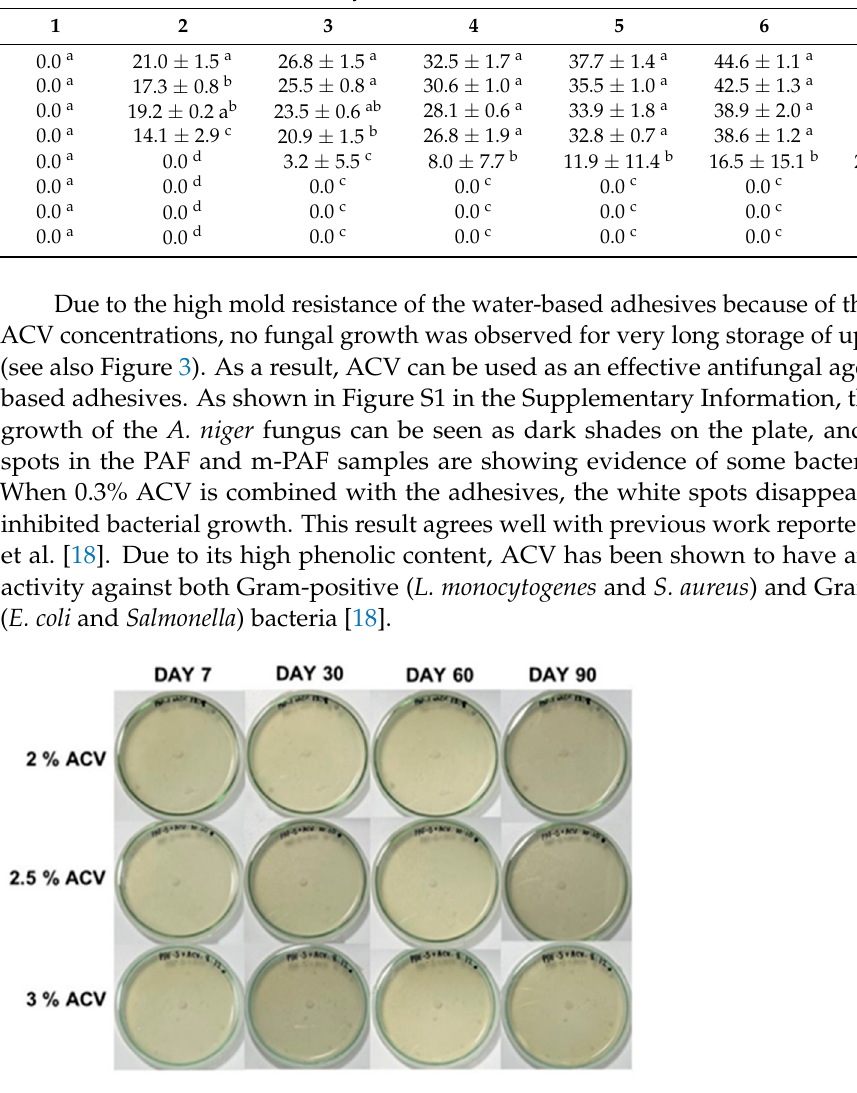
Figure 3. The fungal growth in the adhesives derived from the PAF or ACV/PAF mixtures at various ACV concentrations after 7, 30, 60, and 90 days of storage.